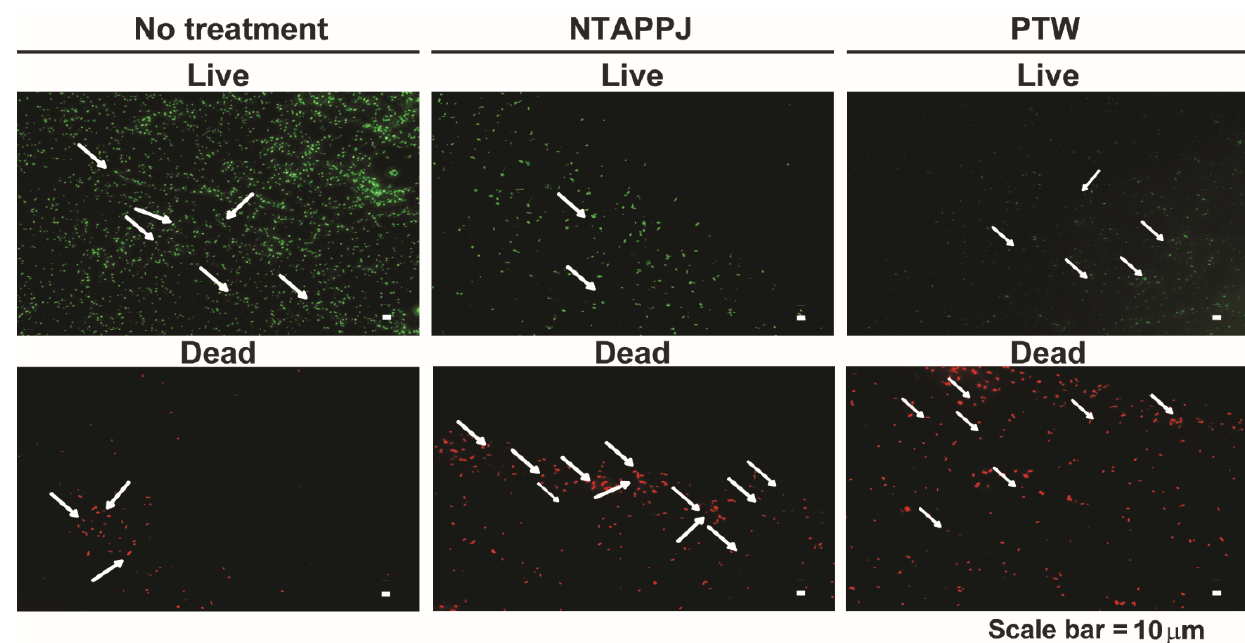
Figure 4. Live and dead bacteria on mushroom surfaces. Images of live (green fluorescence) and dead (red fluorescence) bacteria on mushroom surfaces with no treatment, NTAPPJ, and PTW. Treatment time was 15 min. Arrows indicate bacteria.